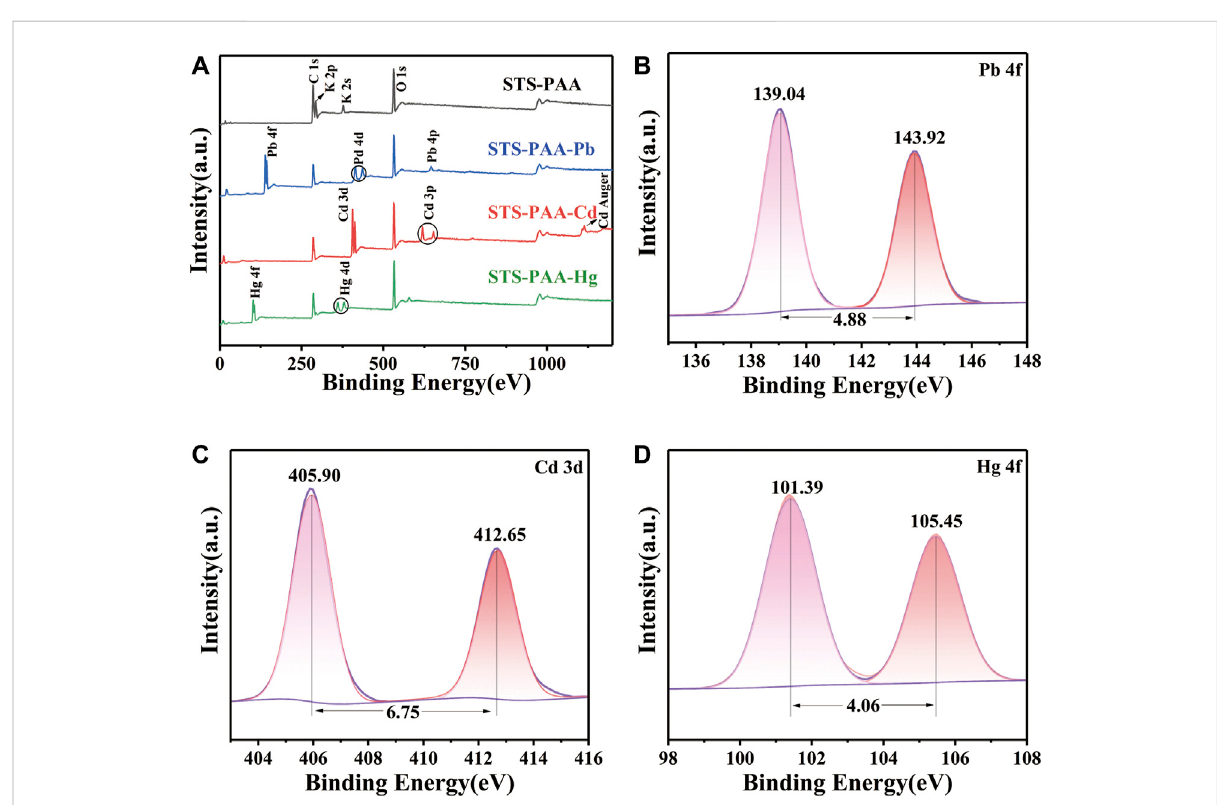
FIGURE 4 XPS spectra of (A) STS-PAA before and after adsorption metal ions, (B) Pb 4f of STS-PAA-Pb, (C) Cd 3d STS-PAA-Cd and (D) Hg 4f of STS-